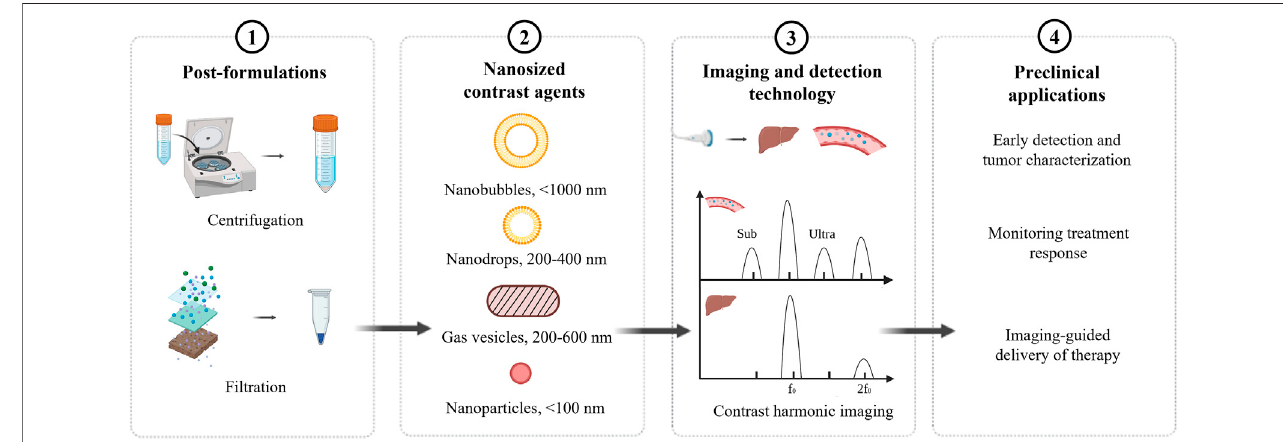
FIGURE 1 | Overview of nanosized contrast